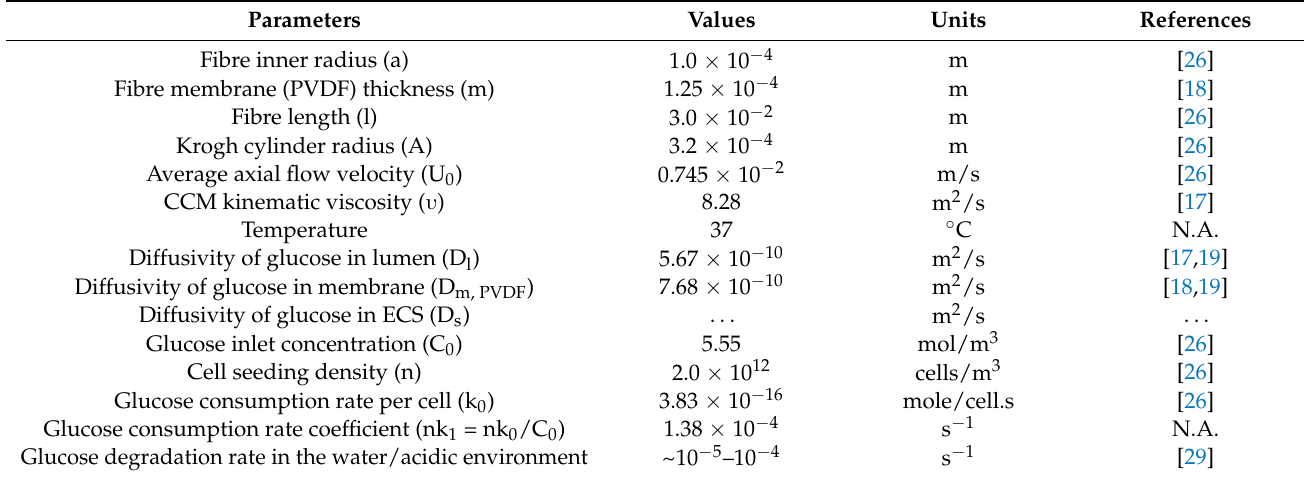
Table 2. Dimensional parameters and their values used in this study.